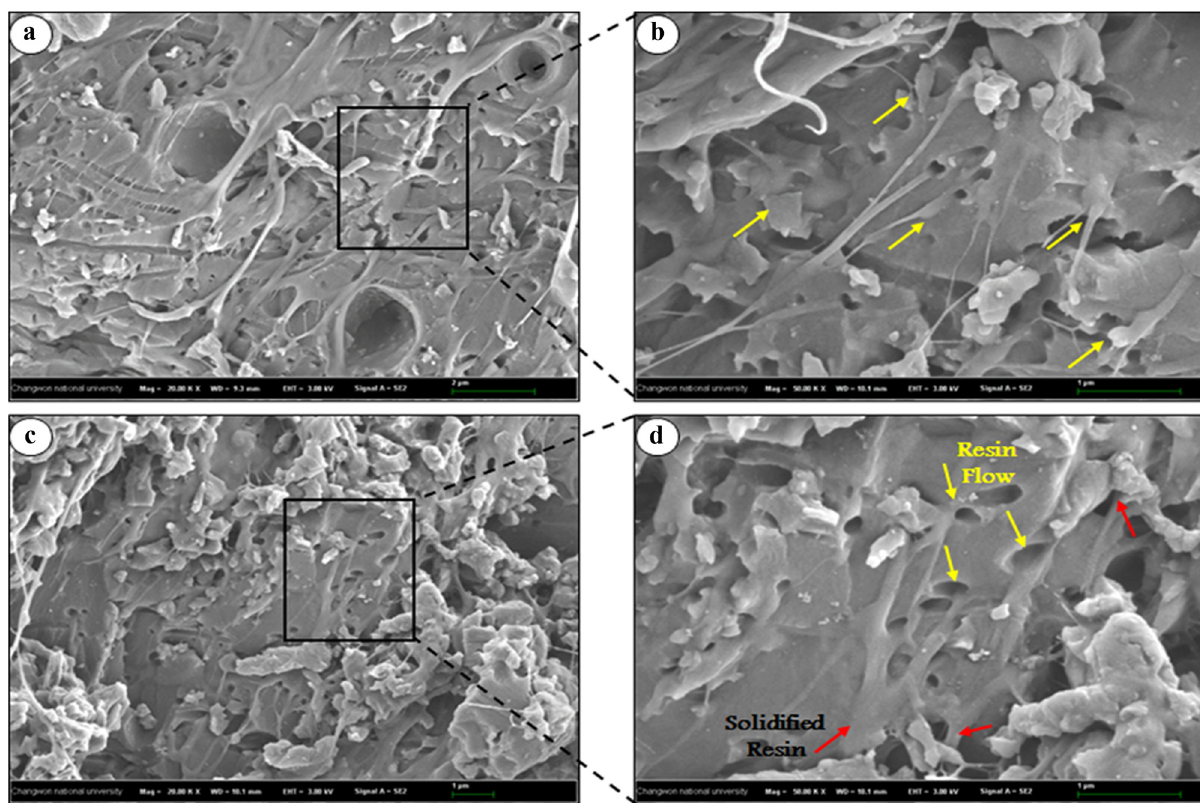
Figure 6: ( a and c ) FESEM images of the fractured surface of CNCPC composites ( b and d ) Higher magni fi cation of ( a ) and ( c ) .